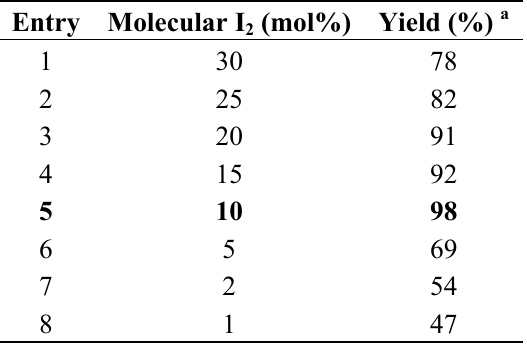
Table 2. Microwave-assisted (300 Watts, 90 °C, 24–50 psi) synthesis of 3-pyrrole substituted 2-azetidinones from 1 mmol of (±)- trans 3-amino-1-(chrysen-6-yl)-4- phenylazetidin-2-one with 1.2 mmol of 2,5-dimethoxytetrahydrofuran using molecular